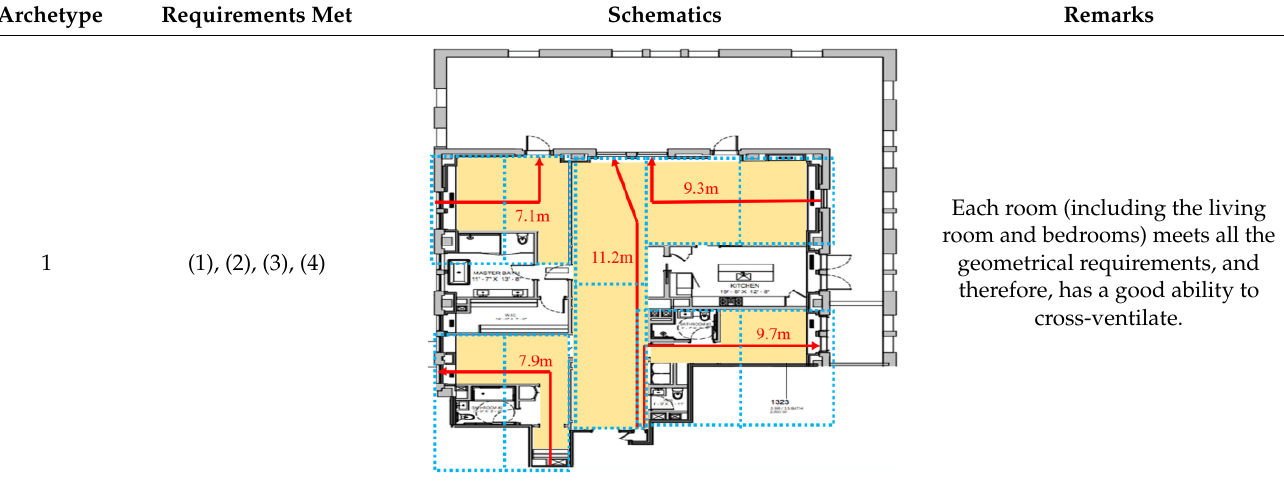
Table A2. The assessments of the cross-ventilation potential for the modelled 15 archetypes.